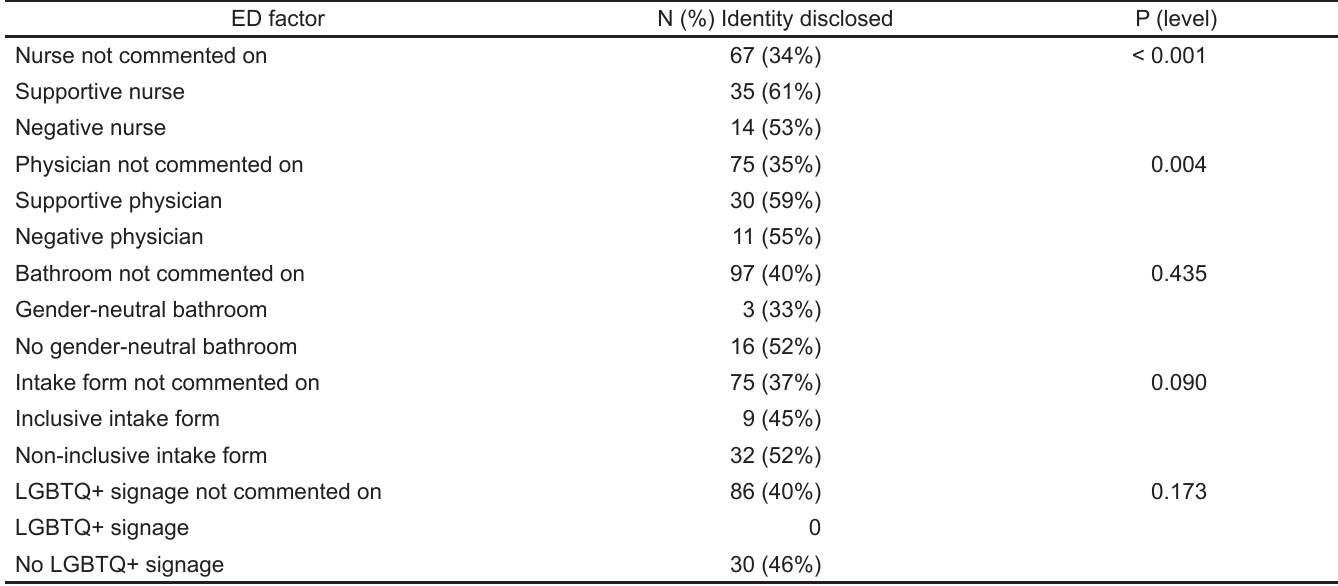
ED , emergency department; LGBTQ+ , lesbian, gay, bisexual, transgender, queer, other.